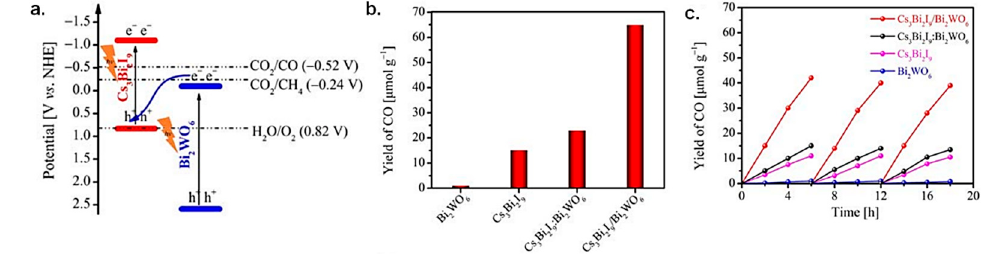
Figure 8. Implementation of an extrinsic approach to increase the efficiency and stability of Cs 3 Bi 2 I 9 : ( a ) Band coupling, ( b ) Comparative CO generation, and ( c ) Stability tests of Cs 3 Bi 2 I 9 –Bi 2 WO 6 heterojunction. Adapted from [137].